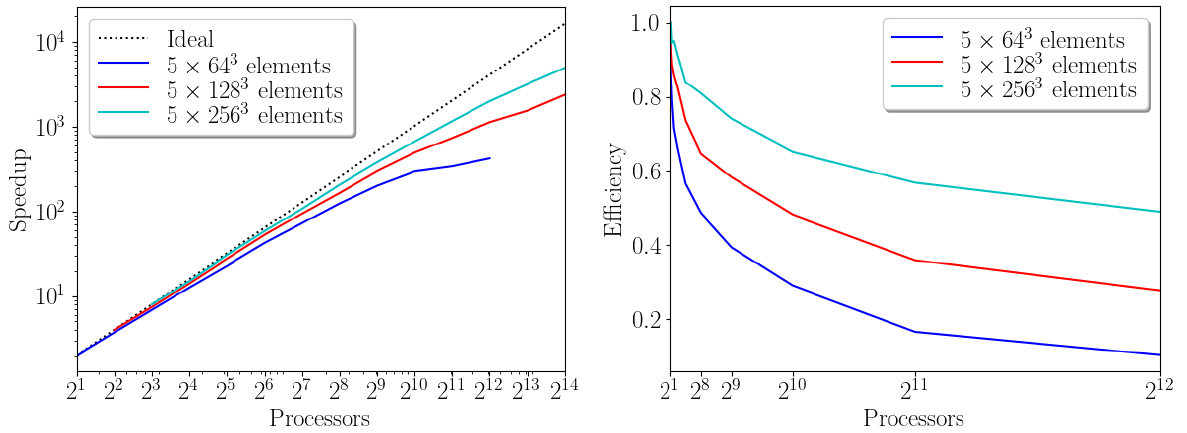
Figure 5. Speedup graph ( left ) comparing the measured and the ideal wall-clock time from 16 to 4096 CPUs, and efficiency graph ( right ) considering three different meshes: 64 3 tetrahedra (in cyan).